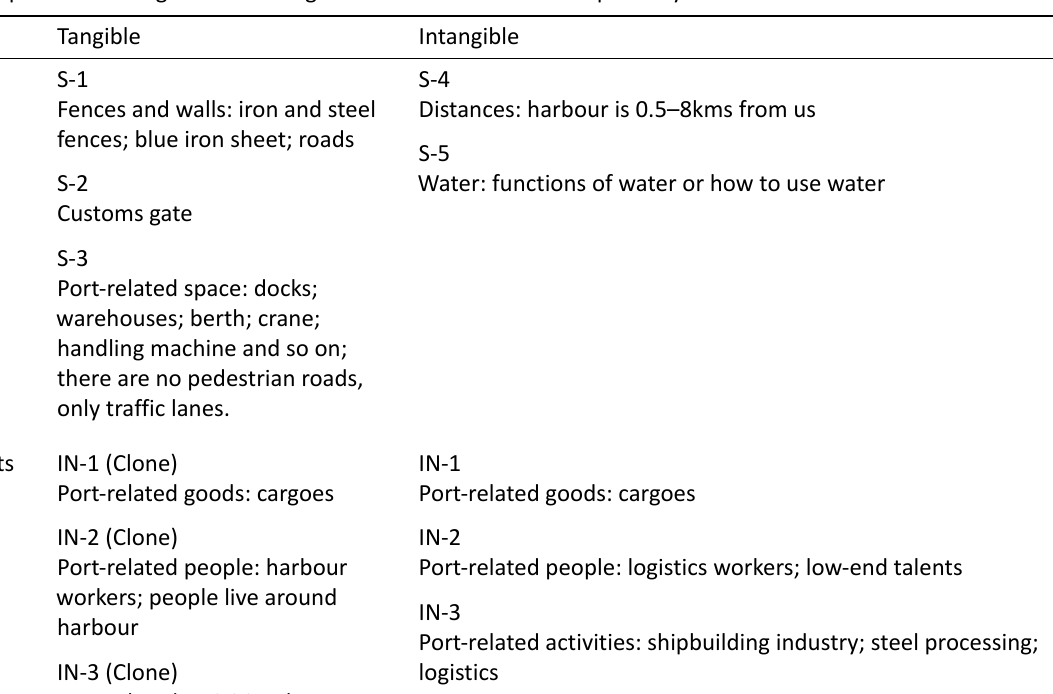
Table 2. The composition of tangible and intangible boundaries at Baoshan port‐city